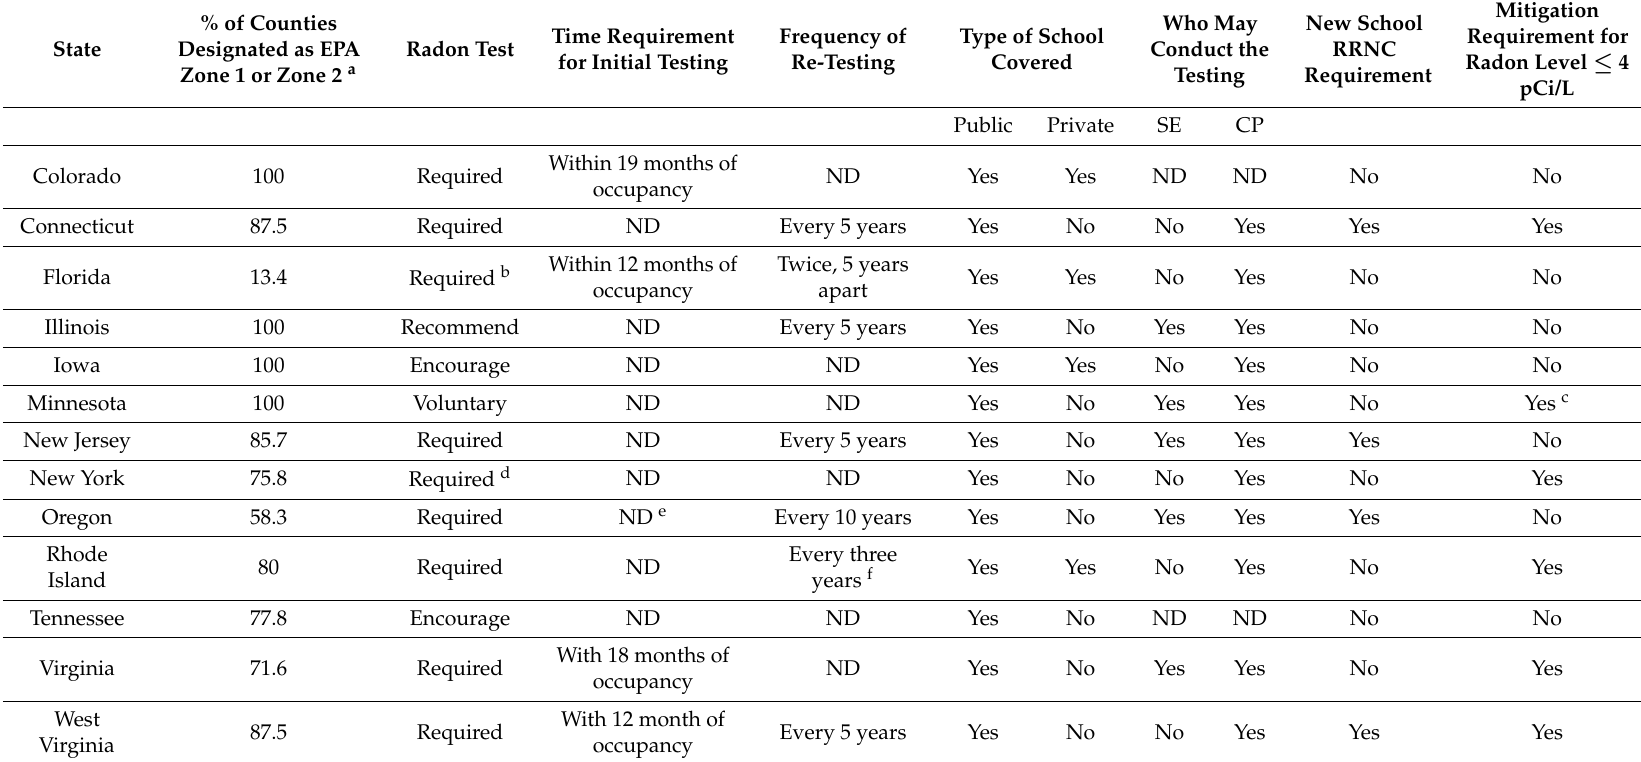
Table 1. Radon testing in schools: State